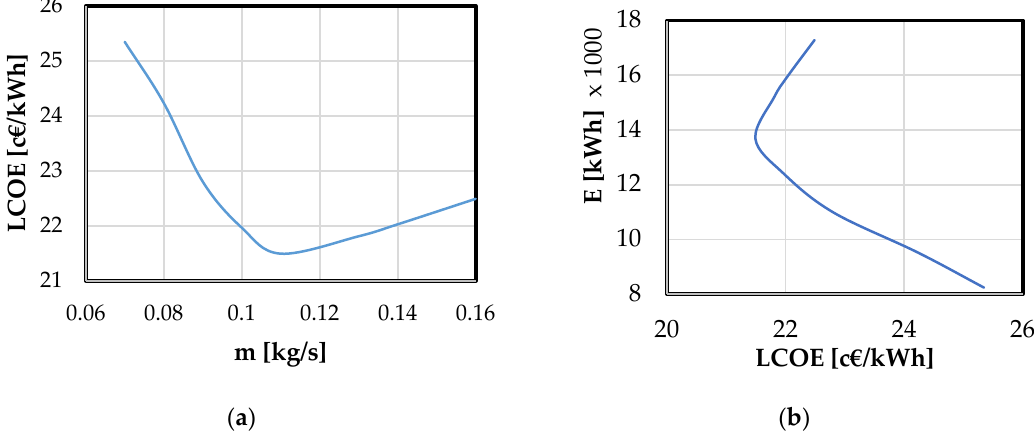
Figure 16. Plant size optimisation results. ( a ) Levelised cost of electricity (LCOE) as a function of the mass flow rate in design condition; ( b ) energy produced during the year as function of the LCOE.